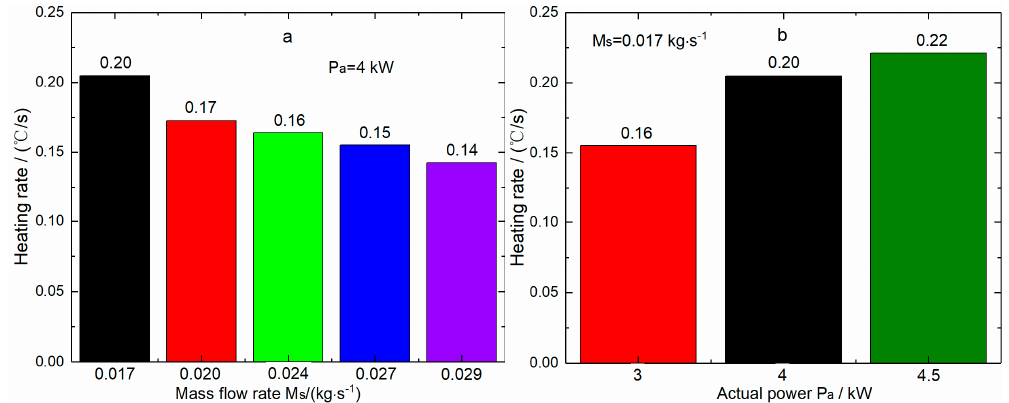
Figure 8. Heating rate versus ( a ) mass flow rate and ( b ) heating power.